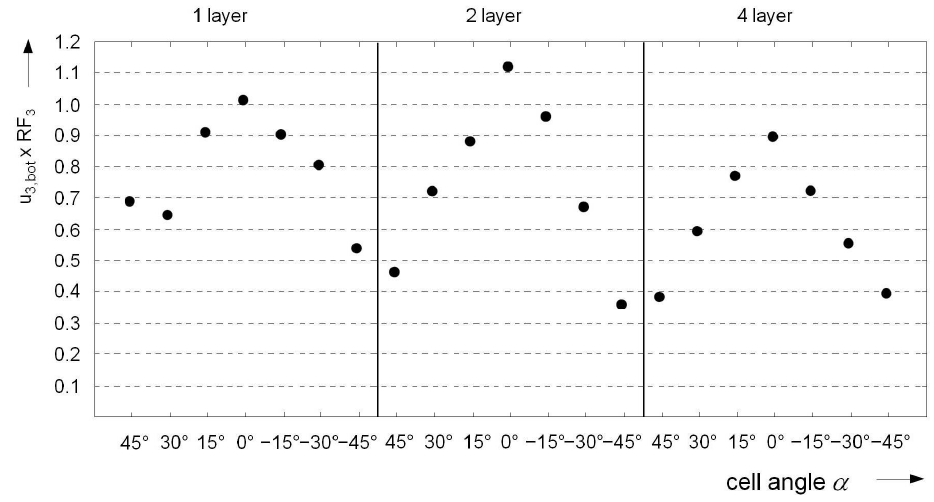
Figure 29. Performance indicator for 3D lattice cores.